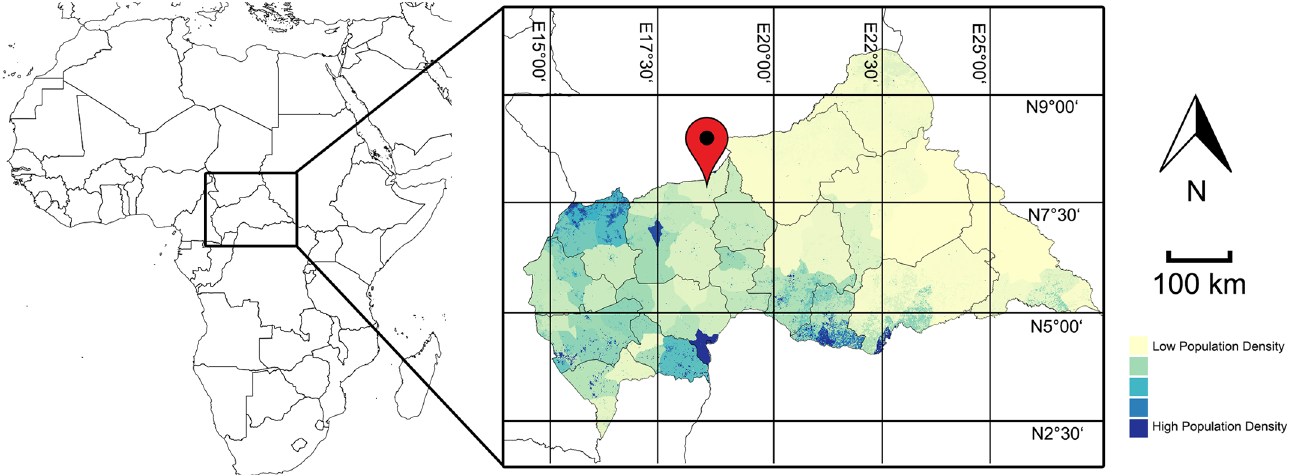
Fig 1. Illustration of the Region of Interest (Kabo) in the Central African Republic (Kabo) and Population Density based on the Worldpop Project (http://www.worldpop.org.uk/).